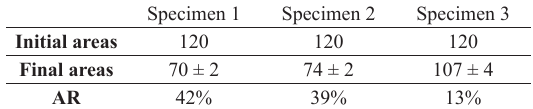
Table 3. Values of the initial areas, final areas and area reduction (AR) of the deformed specimens.